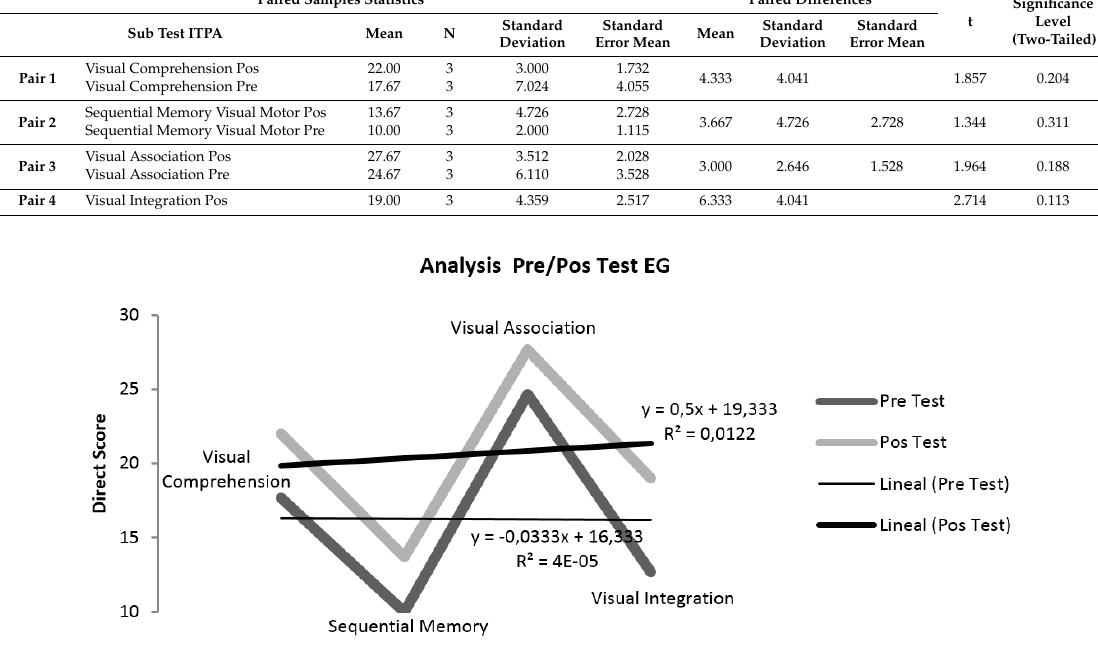
Figure 5. Pre / Post-Test Analysis in Experimental Group (EG). Figure 5. Pre/Post-Test Analysis in Experimental Group (EG).